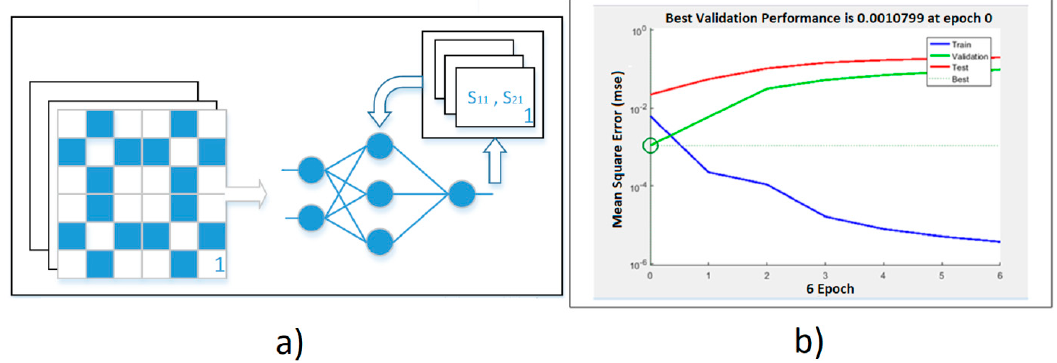
Figure 4. ( a ) Resonator plane and artificial neural network working principle and ( b ) neuron training results .